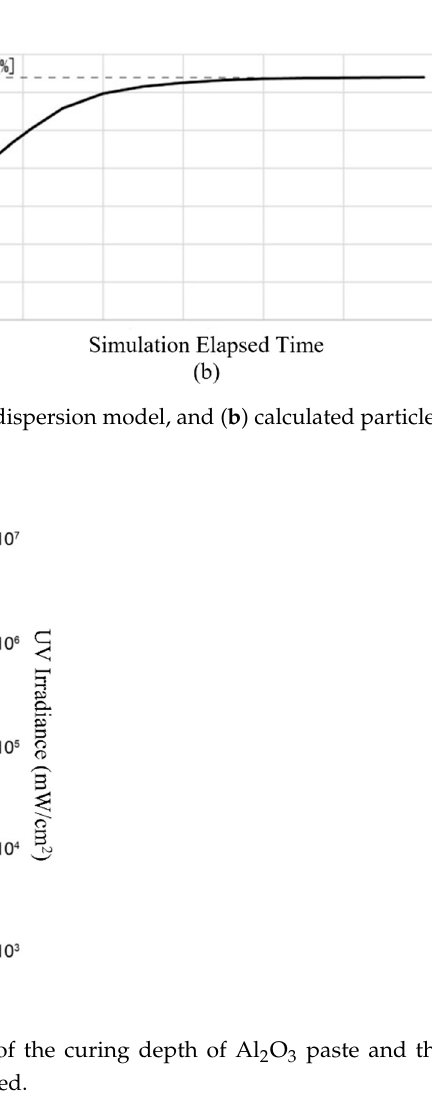
Figure 5. Schematic of thermal treatment process of stereolithography composite “green” parts.